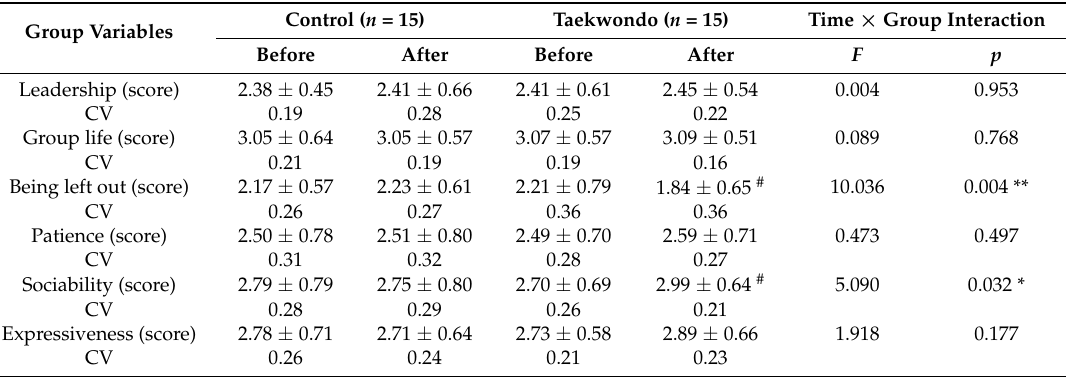
Table 5. Changes in sociability.